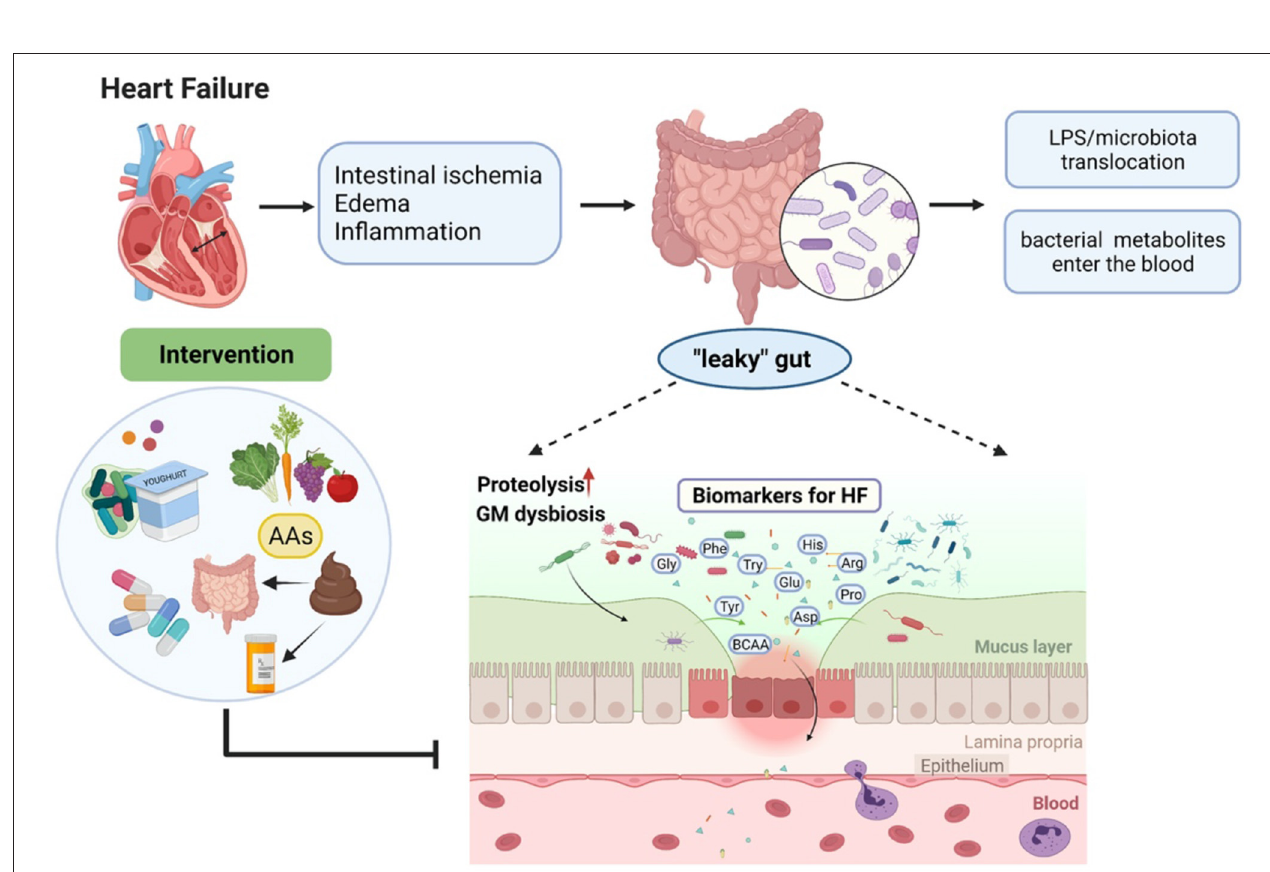
FIGURE 1 | Heart failure (HF)-caused gut microbiota dysbiosis leads to metabolite disorders and therapeutic interventions.